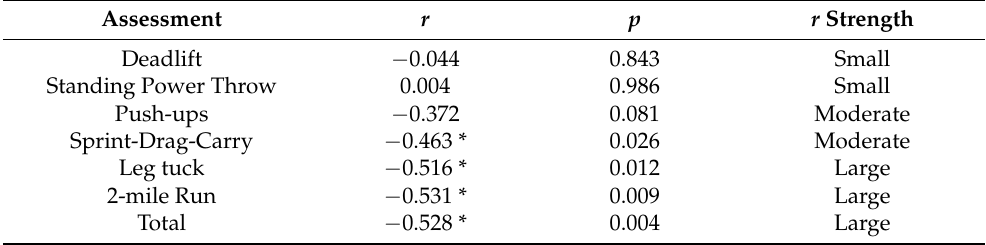
Table 3. Partial correlations (controlling for sex) with the tactical foot march and Army Combat Fitness Test event (3-repetition maximum deadlift (deadlift), standing power throw, hand-release push-ups (push-ups), sprint-drag-carry, leg tuck, 2-mile run) raw scores in ROTC cadets ( N = 29). Assessment r p r Strength Deadlift − 0.102 0.644 Small Standing Power Throw 0.021 0.925 Small Push-ups − 0.366 0.086 Moderate Sprint-Drag-Carry 0.503 * 0.014 Large Leg Tuck − 0.512 * 0.013 Large 2-mile Run 0.506 * 0.014 Large